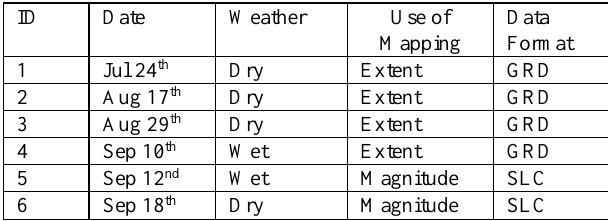
Table 1. Basic information of all SAR and InSAR acquisitions